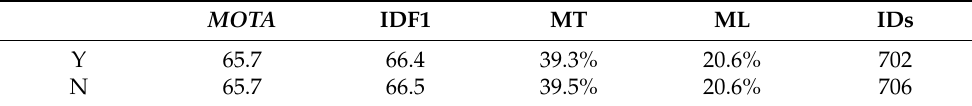
Table 4. Comparison of aggregated and non-aggregated mid-layer outputs. We aggregate output with layers four layers and layers eight and compare them with the original model. Y is with aggregation, and N is without aggregation.